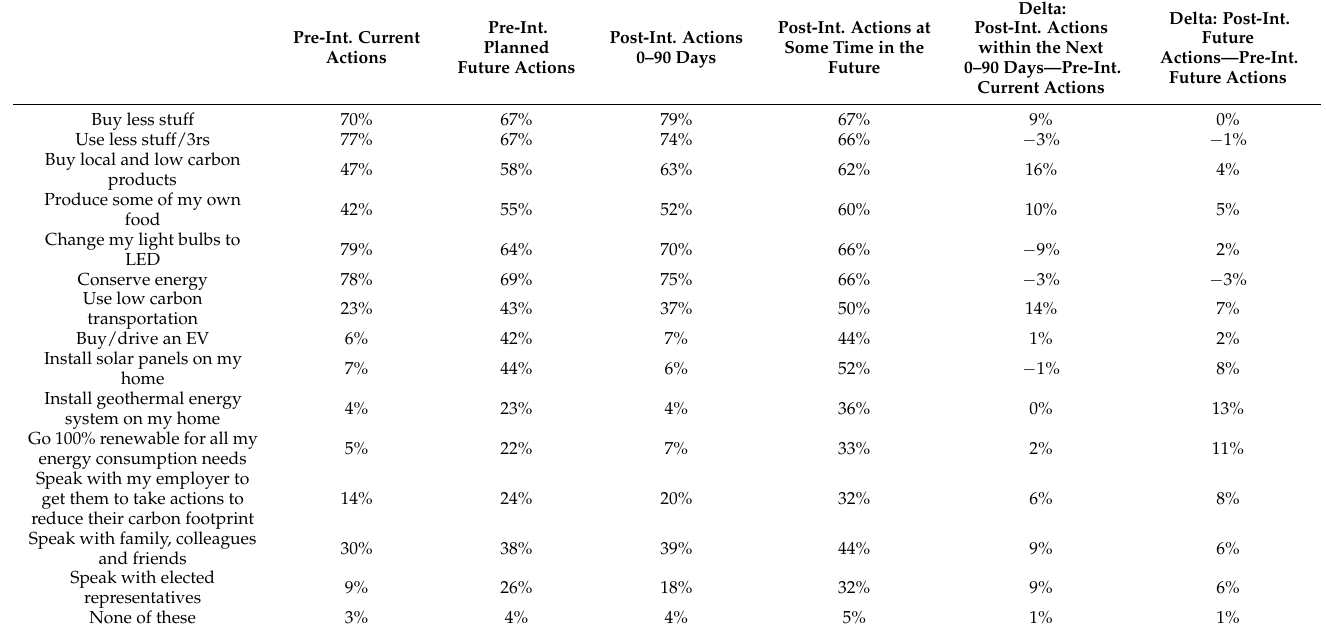
Table 4. Comparison of Short-term and Long-term Mitigating Actions Pre- and Post-intervention.